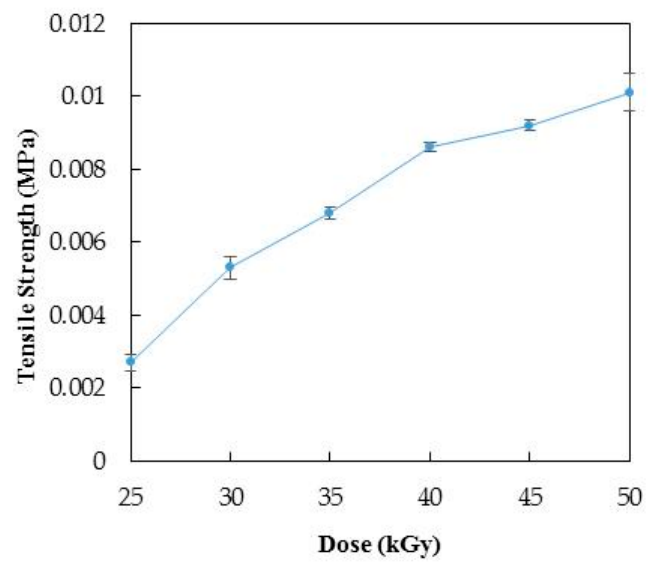
Figure 3. E ff ect of radiation dose on tensile strength of PA15 hydrogel. Figure 3. Effect of radiation dose on tensile strength of PA15 hydrogel.